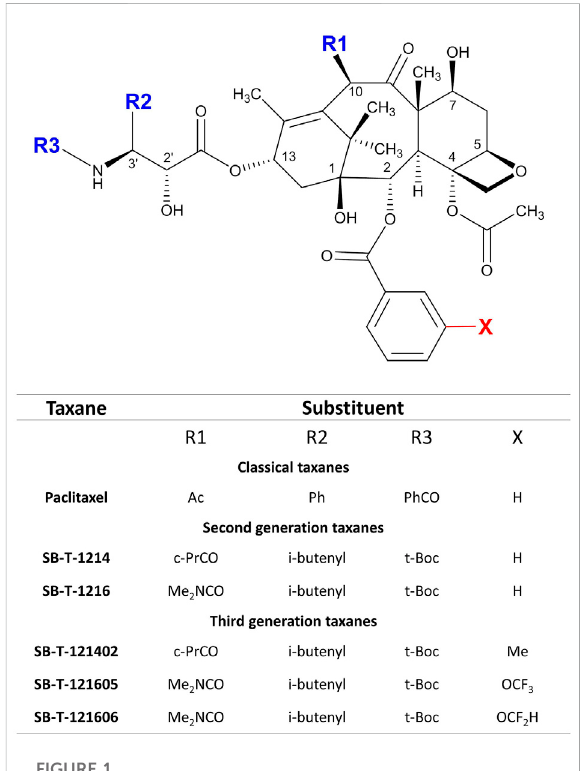
FIGURE 1 Scheme of structure modi fi cations in second and third generation of SB-Ts in comparison to conventional